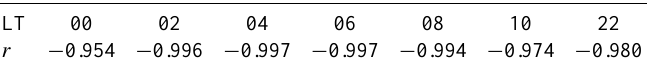
Table 3. The correlation coefficient r [ (k(obs) + 1k),k(A p ) ] for various LT moments